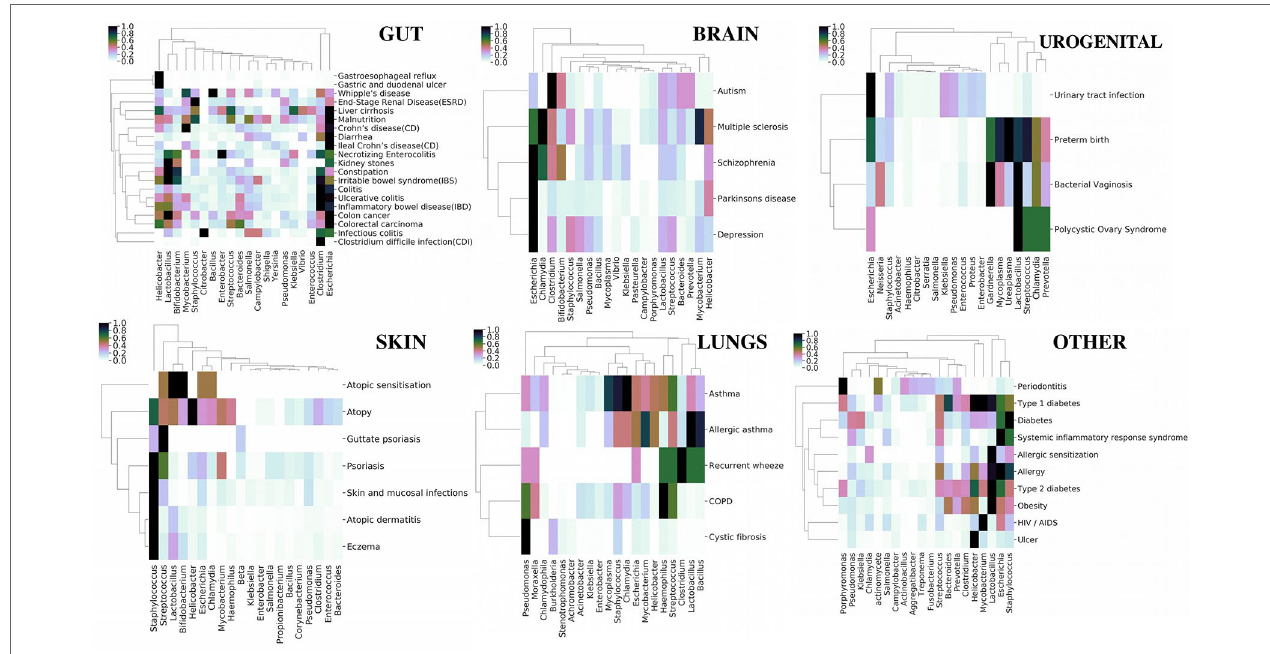
FIGURE 4 | Category-wise (organs affected by various diseases) bidirectionally clustered heat maps based on microbial associations. The top 20 persistent microbes across the six categories ( Table 1 ) were chosen and used to generate bidirectionally clustered (UPGMA hierarchical clustering) heat map for each category. Euclidean distance was used as the measure of distance, and the values were normalized by rows (diseases).